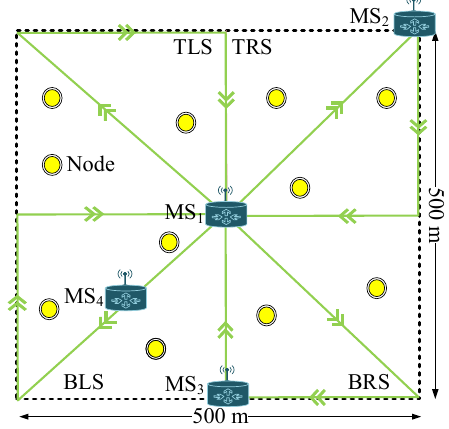
Figure 1. Proposed network. MS, mobile sink; TRS, top right square; TLS, top left square; BRS, bottom right square; BLS, bottom left